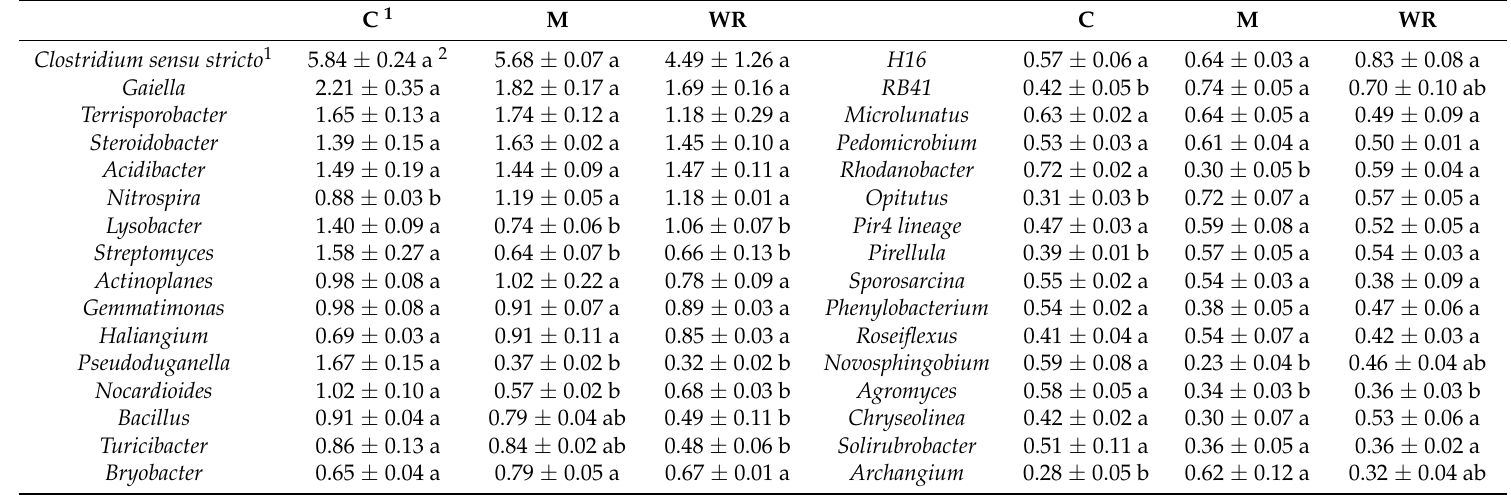
Table 2. Relative abundances (%) of main bacterial genera in cucumber rhizosphere soils. Bacterial genera with average relative abundances >0.50% in at least one treatment were